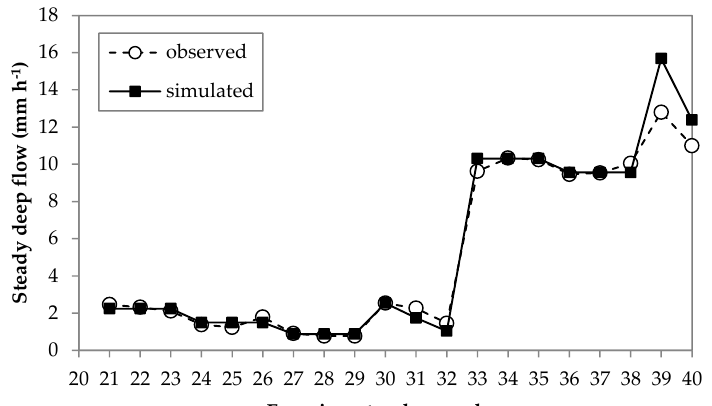
Figure 8. Comparison of the observed and simulated steady deep flow for the different validation experiments.